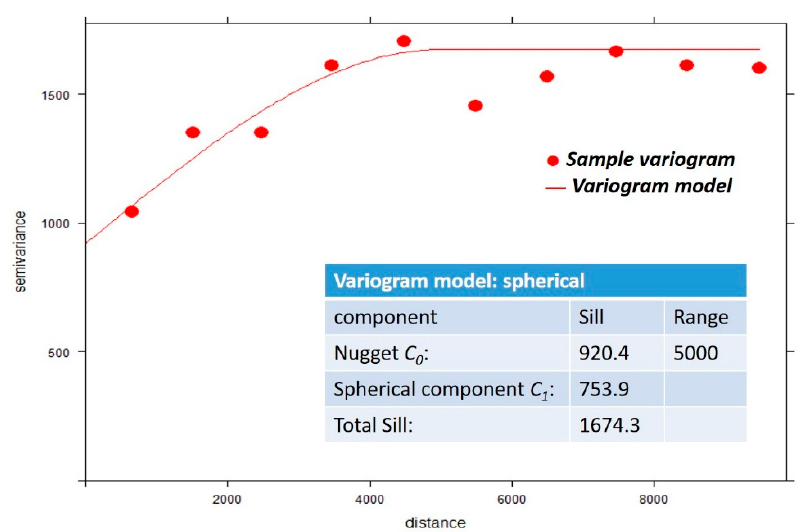
Figure 5. Experimental semivariogram with the spherical model fitted at Ptolemaida mine area.